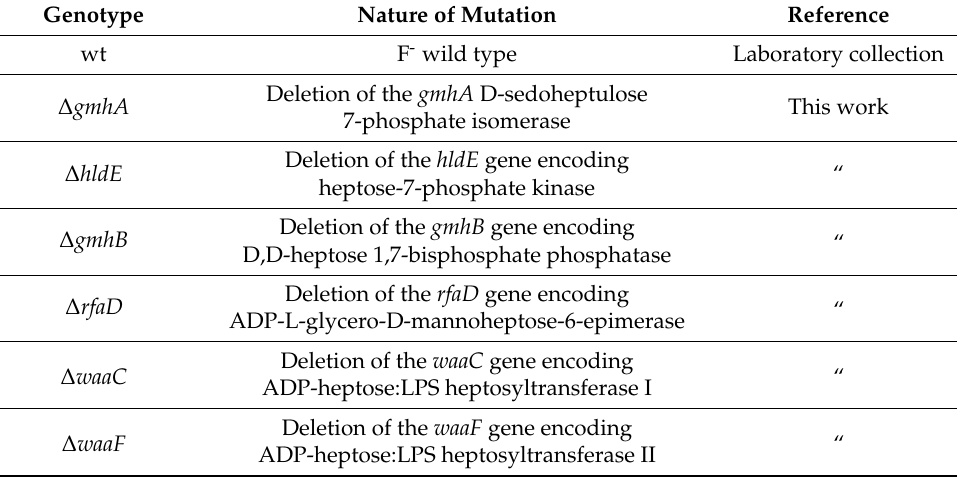
Table 1. Genotype of obtained mutants with deletions of LPS biosynthesis genes.